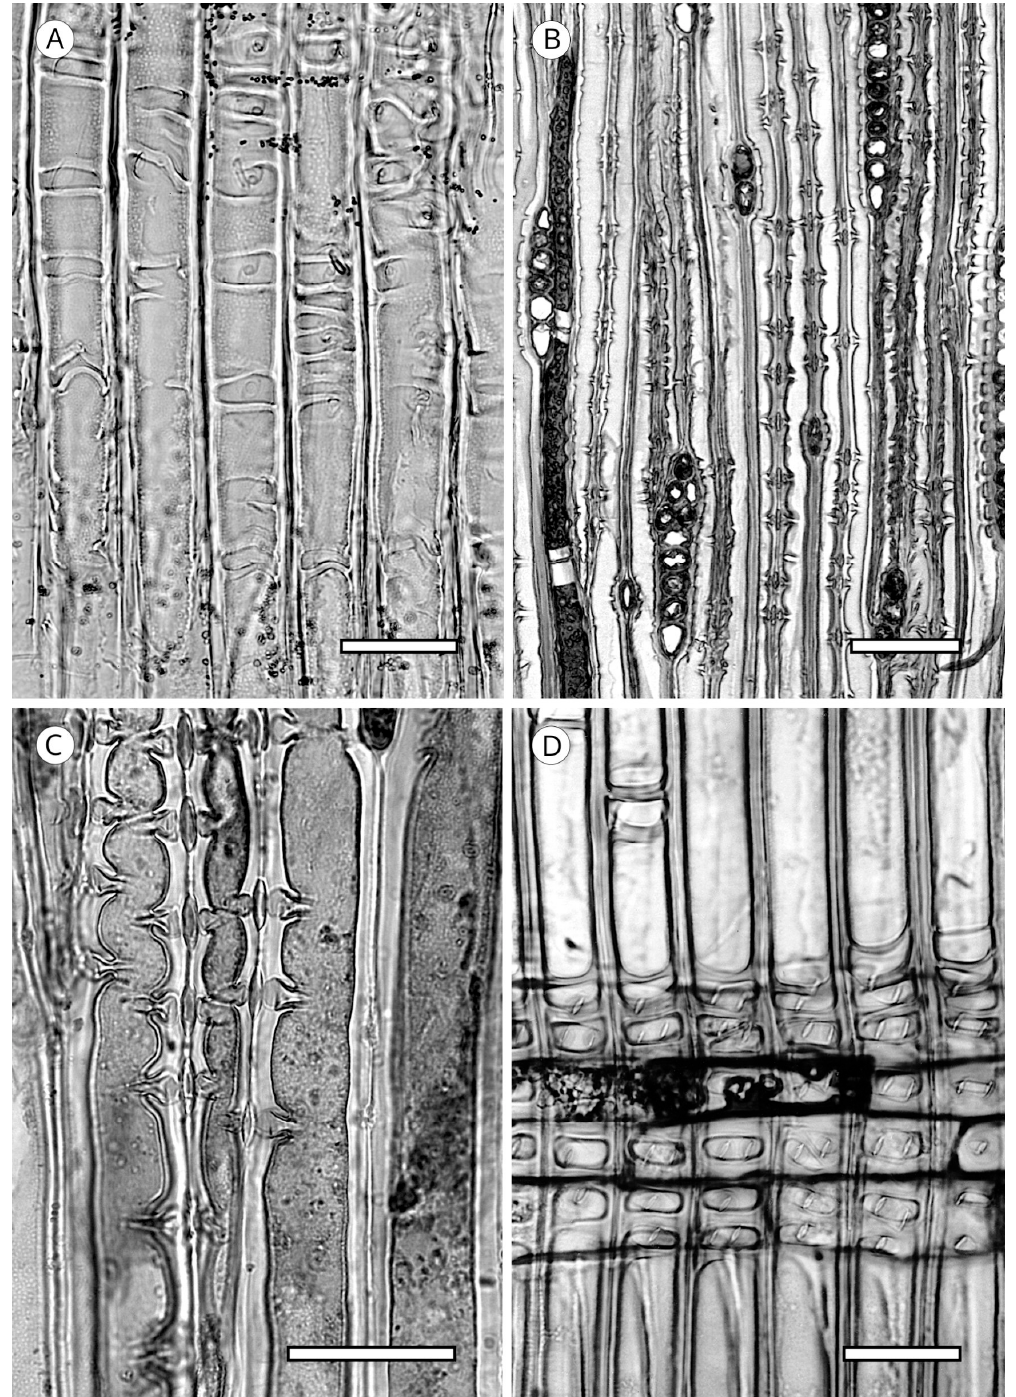
Figure 22. Callitroid thickenings. ( A ) In axial tracheids (radial section) in Callitris columellaris F.Muell.; ( B , C ) In axial tracheids (tangential section) in Callitris endlicheri (Parl.) F.M.Bailey; ( D ) In cross-fields (radial section) in Callitris columellaris F.Muell. Scale bars. ( A , C , D ) = 50 µ m; ( B ) = 100 µ